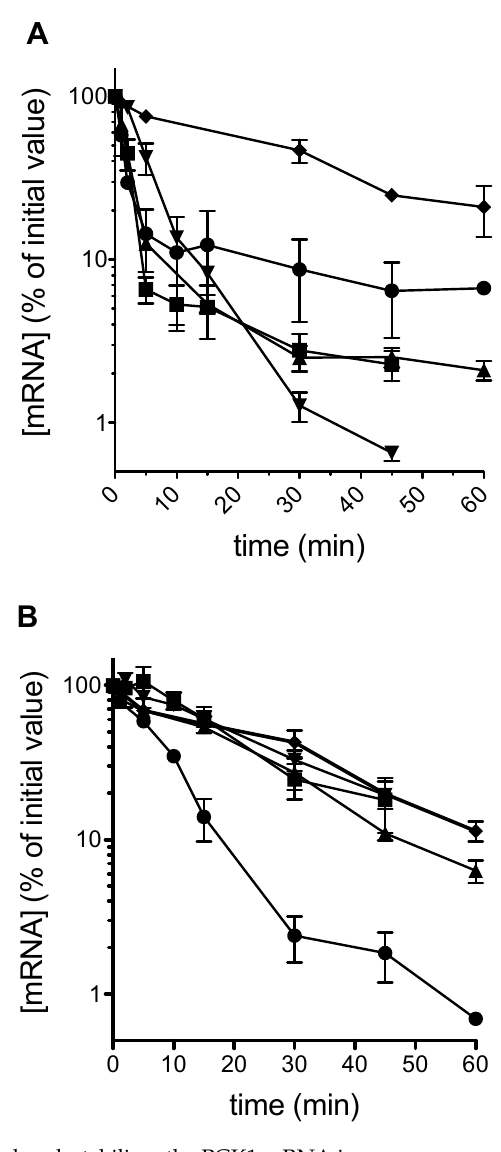
Figure 1. An early stop codon destabilizes the PGK1 mRNA in a nonsense-mediated decay independent manner. The mRNA stabilities of a panel of PGK1 reporter mRNAs were measured in a wild-type ( UPF1 , panel A ) or nonsense-mediated decay defective ( upf1 , panel B ) genetic background. The PGK1 reporter mRNAs contained a single UAA premature stop codon at one of codon positions 22 (circle), 142 (square), 225 (triangle) or 319 (inverted triangle), and were compared against the wild-type PGK1 allele (diamonds). Measurements were made in independent biological replicates ( n = 3, ± standard deviation).